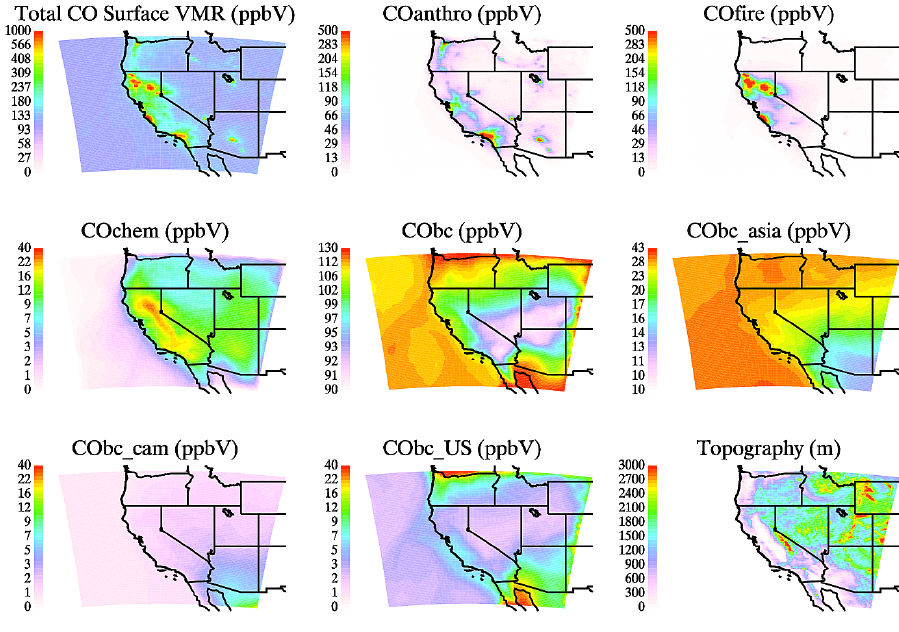
Figure 8 975 Fig. 8. Maps of surface mixing ratios (ppbV) of total CO and CO tracers averaged for 20 June–15 July and of domain topography